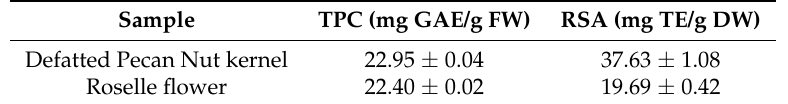
Table 1. Total phenolic compounds and radical scavenging activity 1